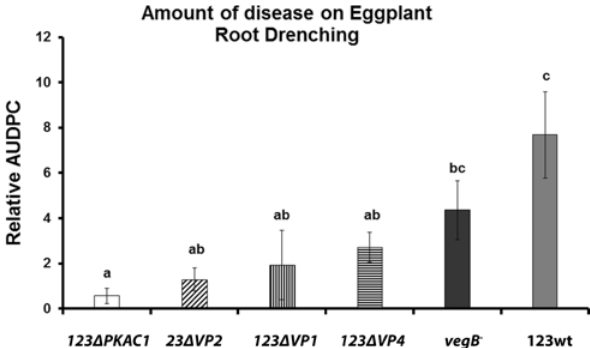
Figure 4. Disease severity caused by the Verticillium dahliae disrup- tion mutants veg Β - , pka C1 - , double disruptants 123Δ VP1 , 123Δ VP2, 123Δ VP4 and the wild type 123wt-r2 on eggplants infected by root drenching. Disease severity was expressed as relative AUDPC. Bars indicate standard errors calculated for 20 replicates. Relative AUD- PC values calculated for each treatment were subjected to analysis of variance and means were separated by Fishers’s least significant deifference (LSD) procedure. Columns with different letters are sta- tistically different at P ≤